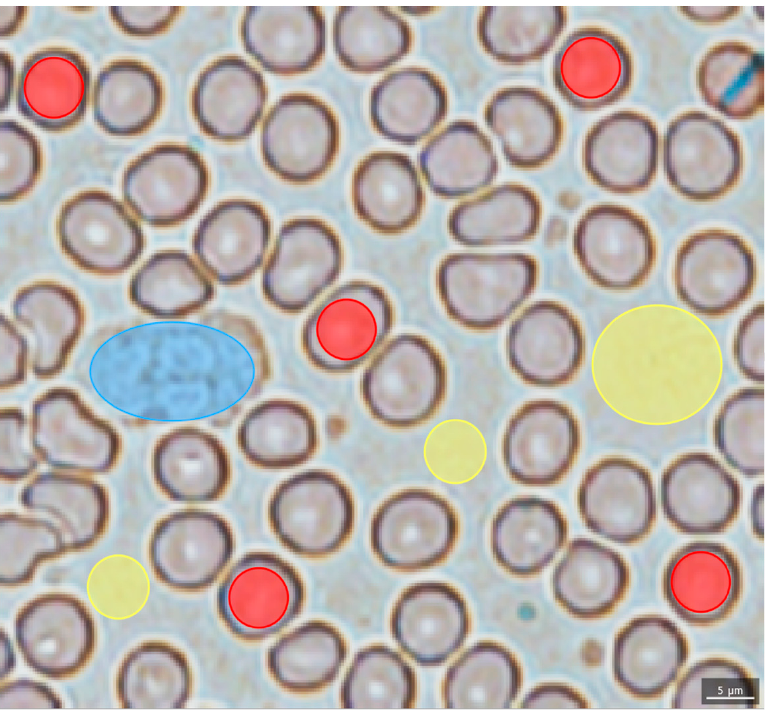
Figure 6. Regions of interest (ROI) selection: red ellipses cover RBCs, light blue ellipse covers WBCs, and yellow ellipses cover plasma remnant regions. Light microscopy image: blood smear covered by a 9AA matrix.